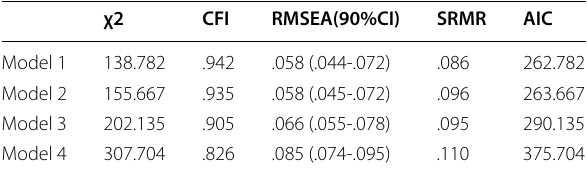
Table 3 The four models of the multi-group confirmatory